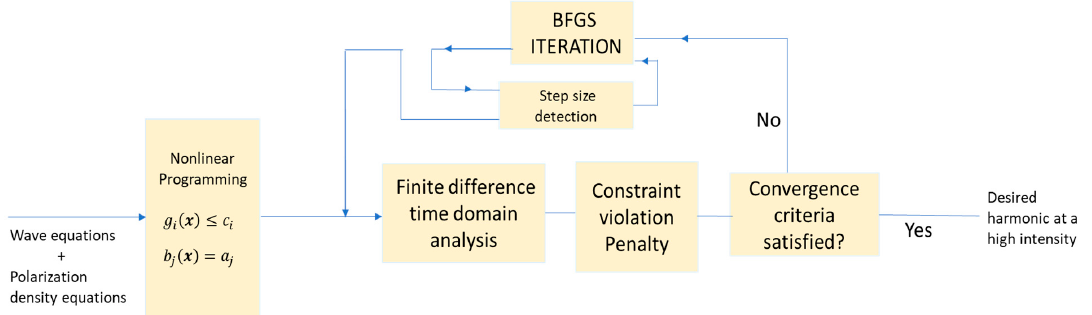
Figure 2. Flowchart description of high-intensity harmonic generation using non-linear programming.